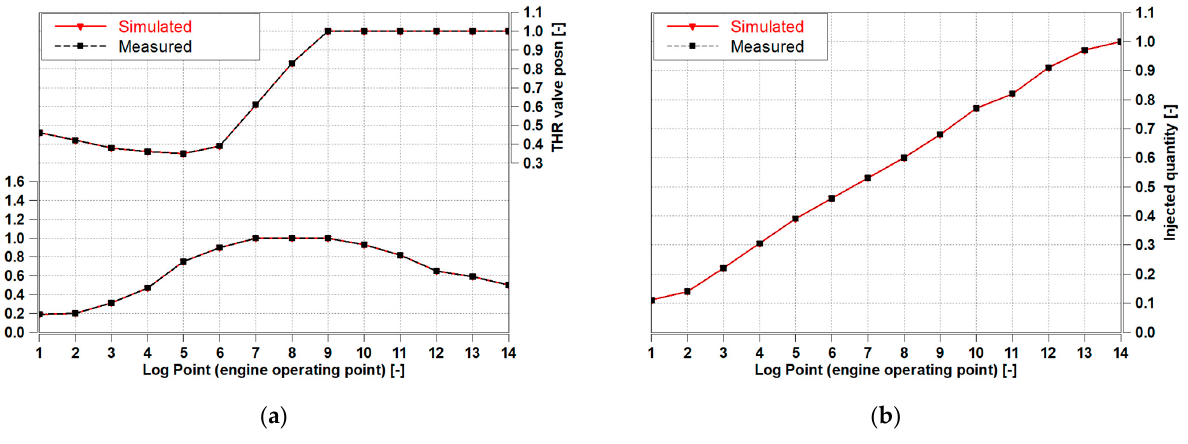
Figure 22. ( a ) Simulated (red) vs measured (black) Intake throttle valve (top) and EGR valve (bottom) positions (normalized with respect to the maximum value reached in the test); ( b ) Simulated (red) vs measured (black) fuel injection (normalized with respect to the maximum value reached in the test).